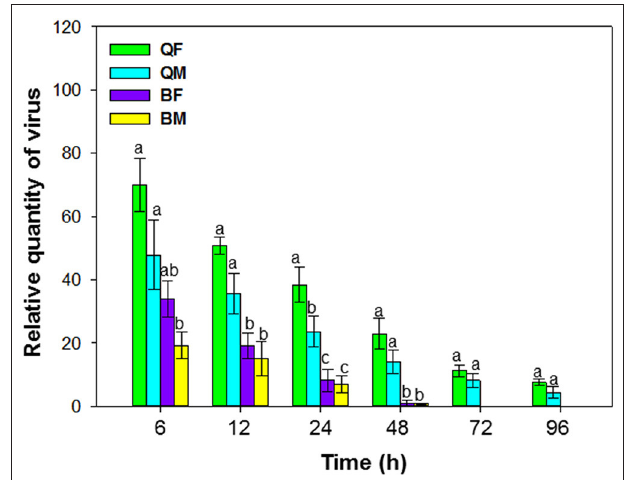
FIGURE 2 | Retention of tomato chlorosis virus by B. tabaci MEAM1 and MED. QF, MED females; QM, MED males; BF, MEAM1 females; BM, MEAM1 males. Values are means ± SE. For each time, means with different letters are significantly different ( P < 0.05; N =